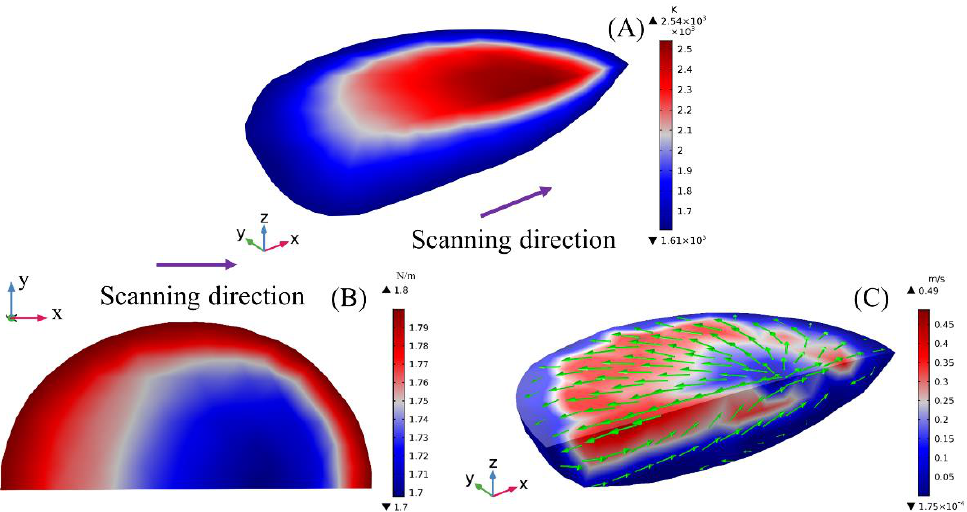
Figure 7. Schematic illustration of the mechanism of surface tension − driven flow. ( A ) Temperature field; ( B ) Surface tension distribution; ( C ) Velocity field.